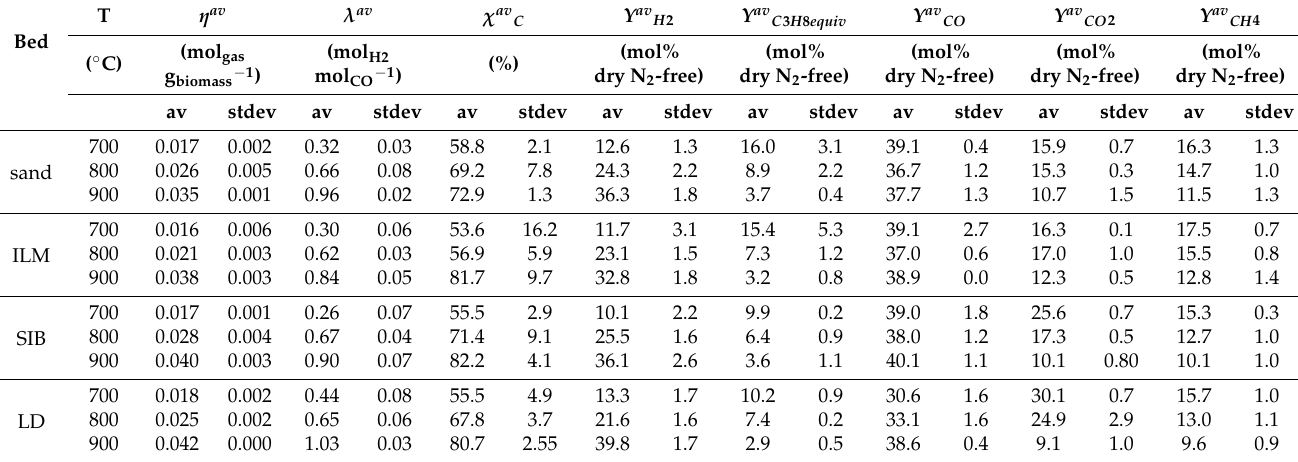
Table A1. Experimental results of WSP devolatilization tests as functions of temperature and kind of bed material (av: average of results from the three individual pellets; stdev: standard deviation of results from the three individual